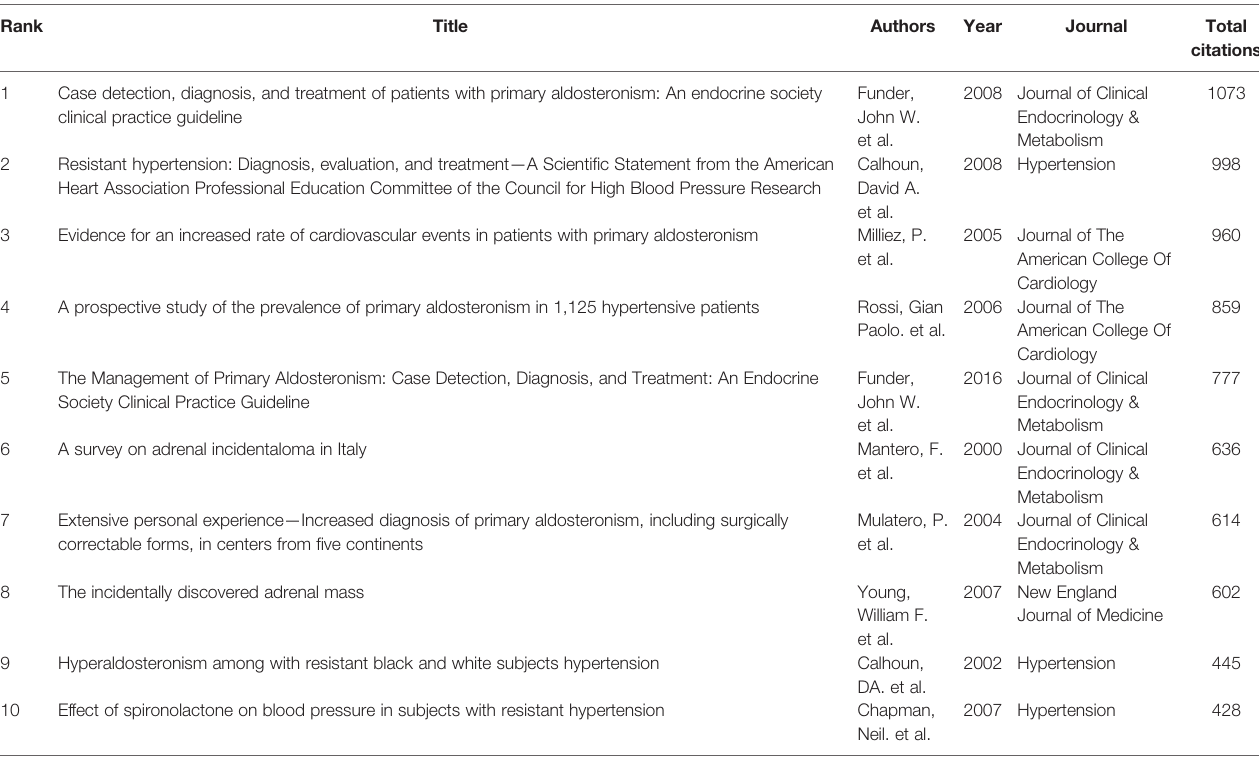
TABLE 4 | The top 10 high-cited papers in PA research during 2000 to 2020.